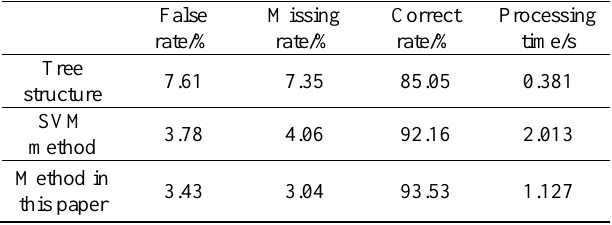
Table 1. Algorithm performance